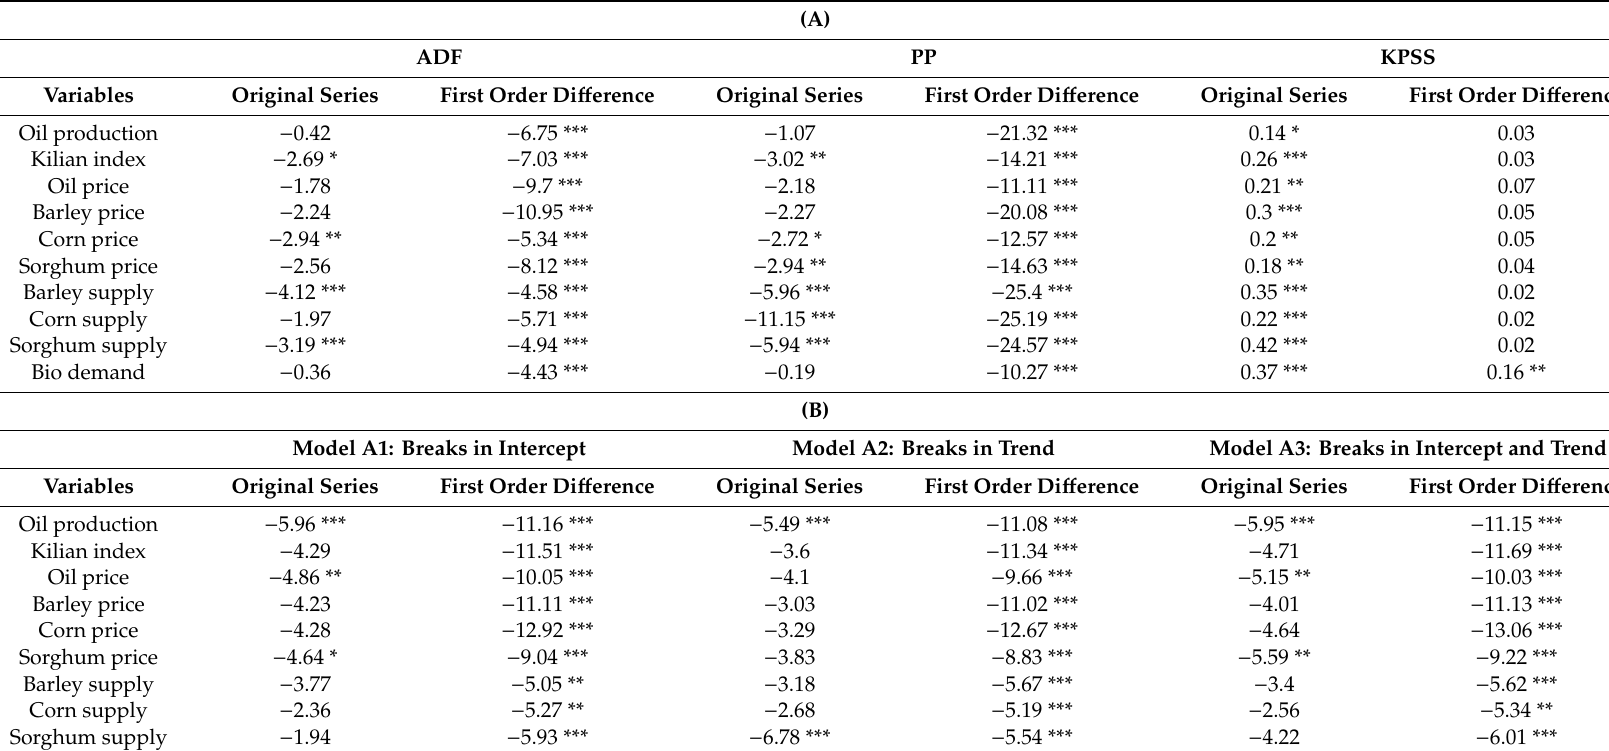
Table 2. (A) Unit root tests without structural break. (B) Unit root test with a structural